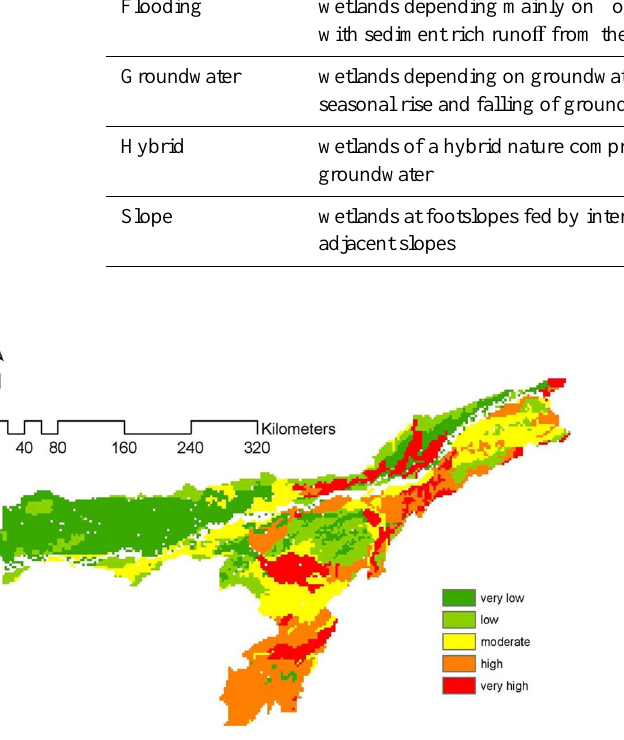
Figure 9. Assam – aquifer vulnerability based on DRASTIC IN- DEX value.